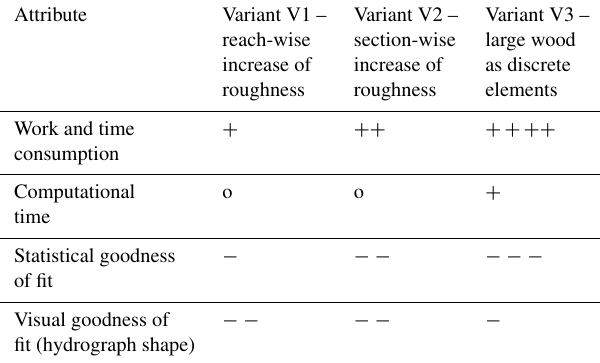
Table 3. Attributes of approaches for large wood implementation applied in this study relative to the reference variant without large wood. Signs indicate that an attribute is higher ( + ), lower ( − ) or equal to (o) the simulation without stable large